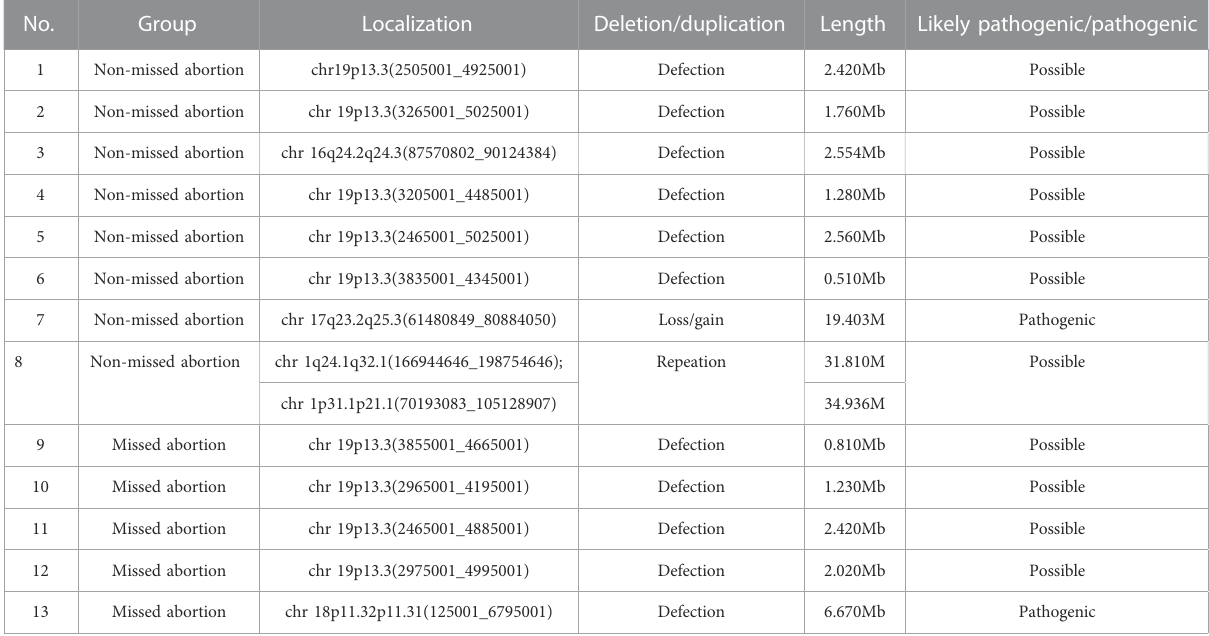
TABLE 5 Likely pathogenic and pathogenic CNVs detected by high-throughput sequencing